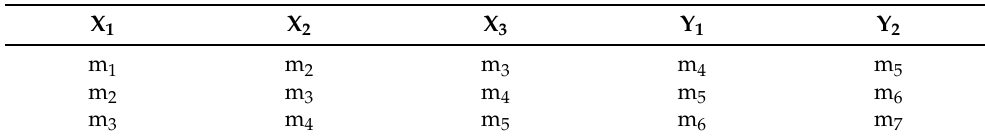
Table 7. The sliding window data for multi-output prediction (X stands for inputs, Y for outputs and m for the monthly